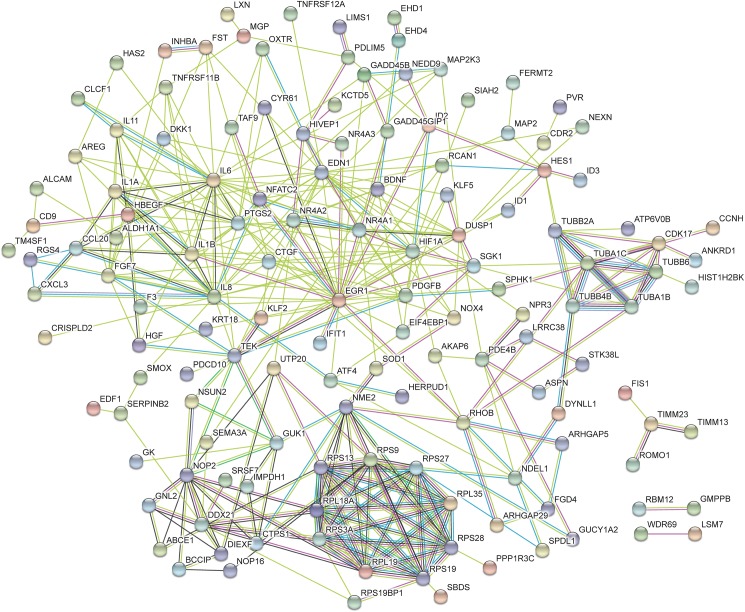
This network represents the differentially expressed genes regulated in thrombin transactivation of the TGFBR1.The functions of this network include biological processes, molecular functions and cellular component. The color of the nodes indicates the query protein and its first shell of interactions. Protein nodes which are enlarged indicates the availability of 3D protein structure information. The colored lines between the nodes indicated the query protein-protein interactions. The known interactions is a light blue (from curated database) or pink (experimentally determined) lines between the proteins. The predicted interactions use green (gene neighborhood), red (gene fusion) and dark blue (gene co-occurrence) lines. The yellow represents text mining, the black represent co-expression and the purple lines represent protein homology.